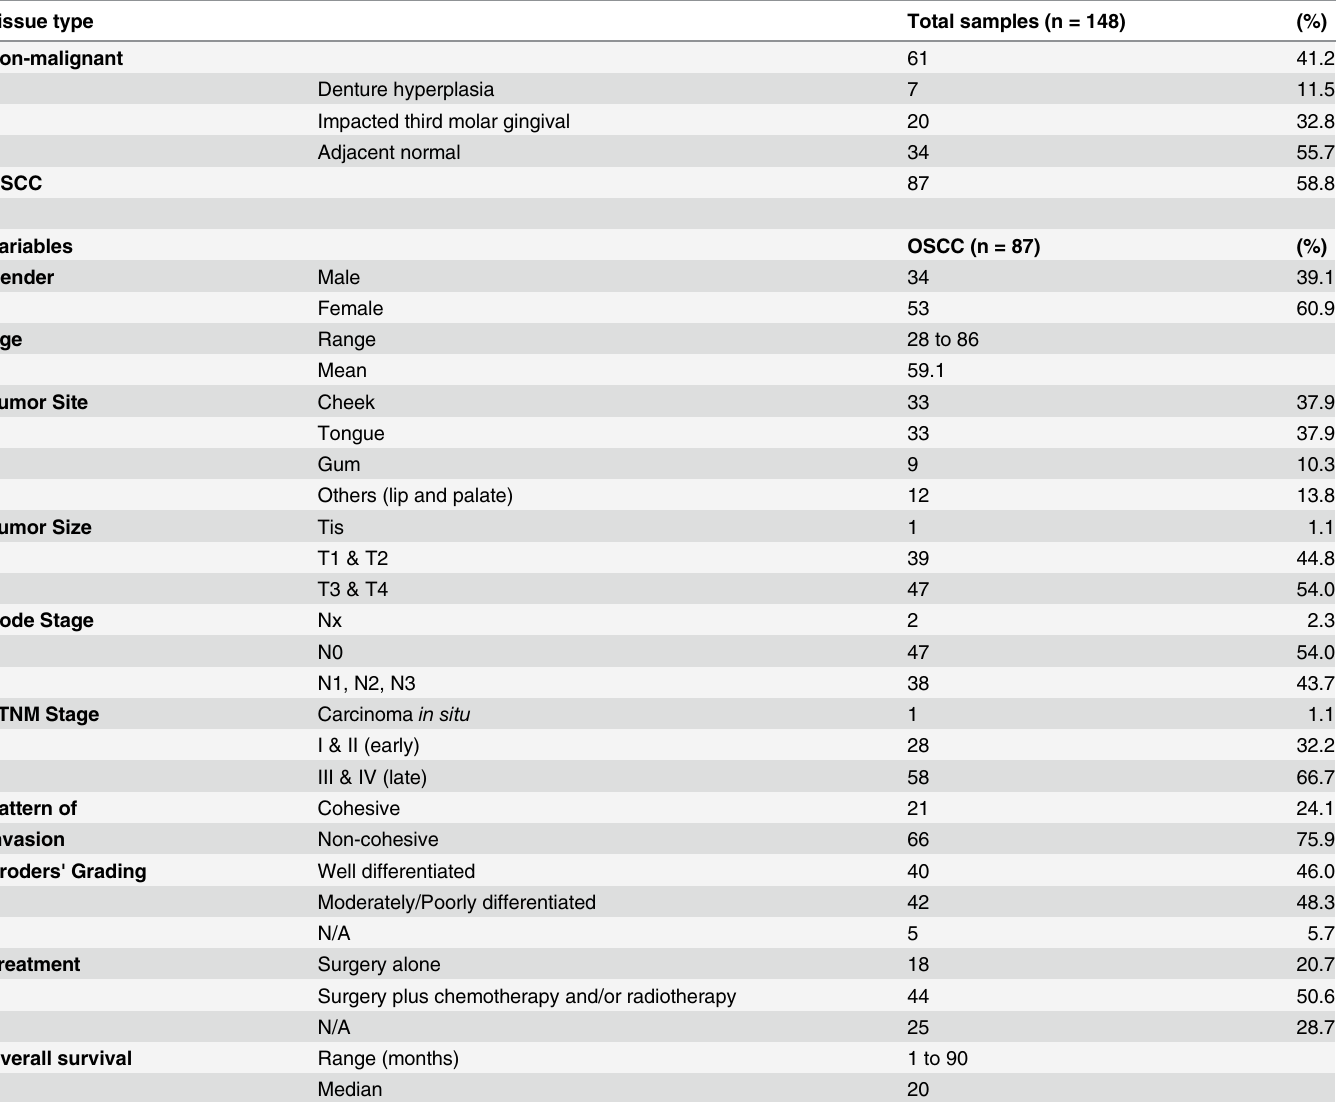
Table 1. Demographics and clinico-pathological characteristics of patients. Tissue